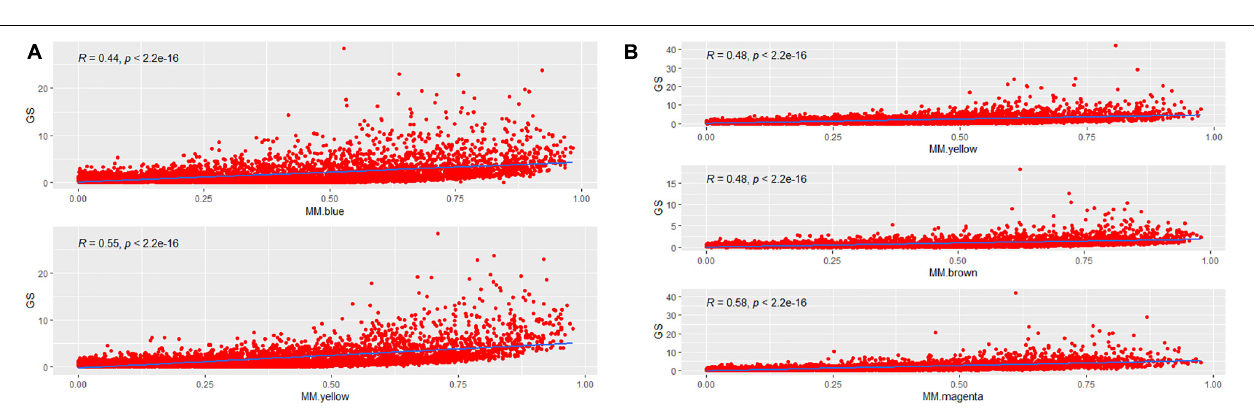
FIGURE 3 | The module–trait associations of networks. (A) Module–trait associations in LAA. Row represents a module eigengene, column indicates disease status – AF or SR. Each cell contained the corresponding correlation and p -value. The table was color-coded by p -value according to the color legend. (B) Module–trait associations in RAA. LAA, left atrial appendage; RAA, right atrial appendage.